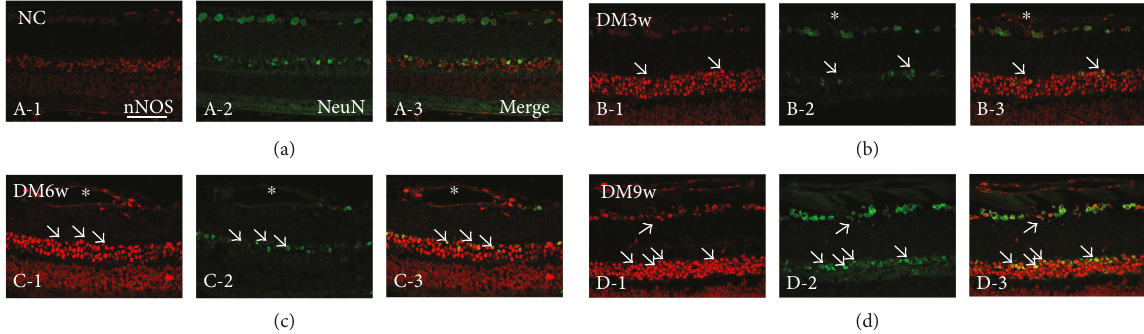
Figure 2: Representative photomicrographs of nNOS (red) and NeuN (green) double staining of the retina in the NC and DM6w groups. nNOS immunoreactivity was localized in NeuN-labeled neurons (single arrow) and blood vessels (asterisk), and it was relatively higher in the DM6w group (B-1) than in the NC group (A-1). Moreover, coexpression of nNOS and NeuN was apparent in the DM6w group (B-3) compared to the NC group (A-3). Blood vessels appeared to be dilated in diabetic retina at the DM6w group (asterisk). Note the enhanced nNOS staining and smaller size of NeuN-positive neurons at the DM6w group compared with the control group. Bar=50 μ